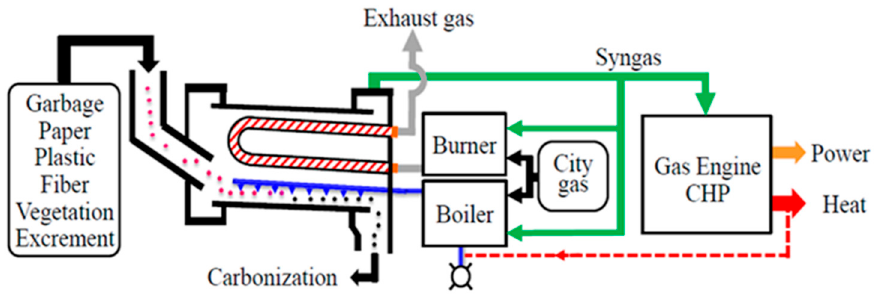
Figure 5. Schematic diagram of superheated steam gasification system.